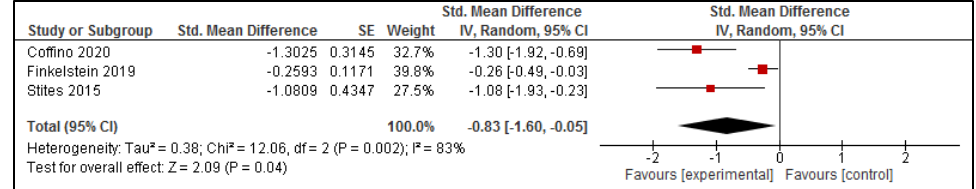
Figure 4. Effect of intervention delivered via online food ordering systems on the Fat content of purchases.